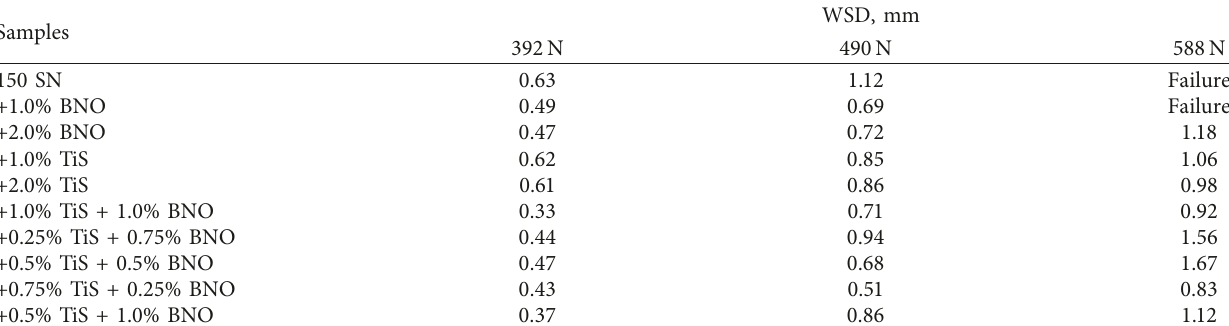
Table 5: Antiwear properties of TiS and BNO.